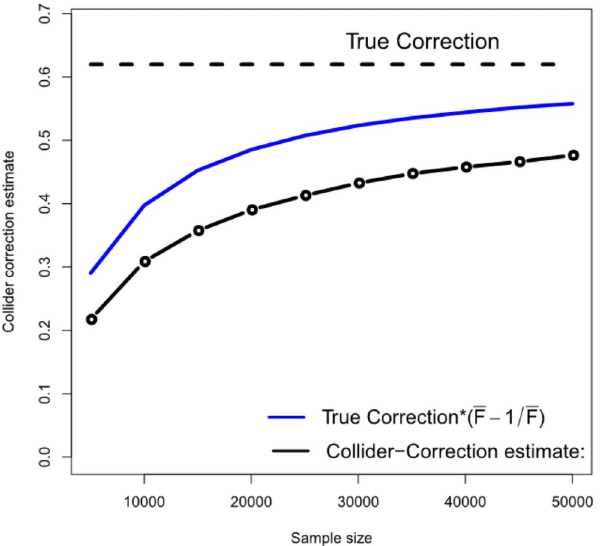
Fig 13. An illustration that the Collider-Correction slope’s dilution under a LAD-regression analysis can be approximately (but not exactly) predicted using the F-statistic.